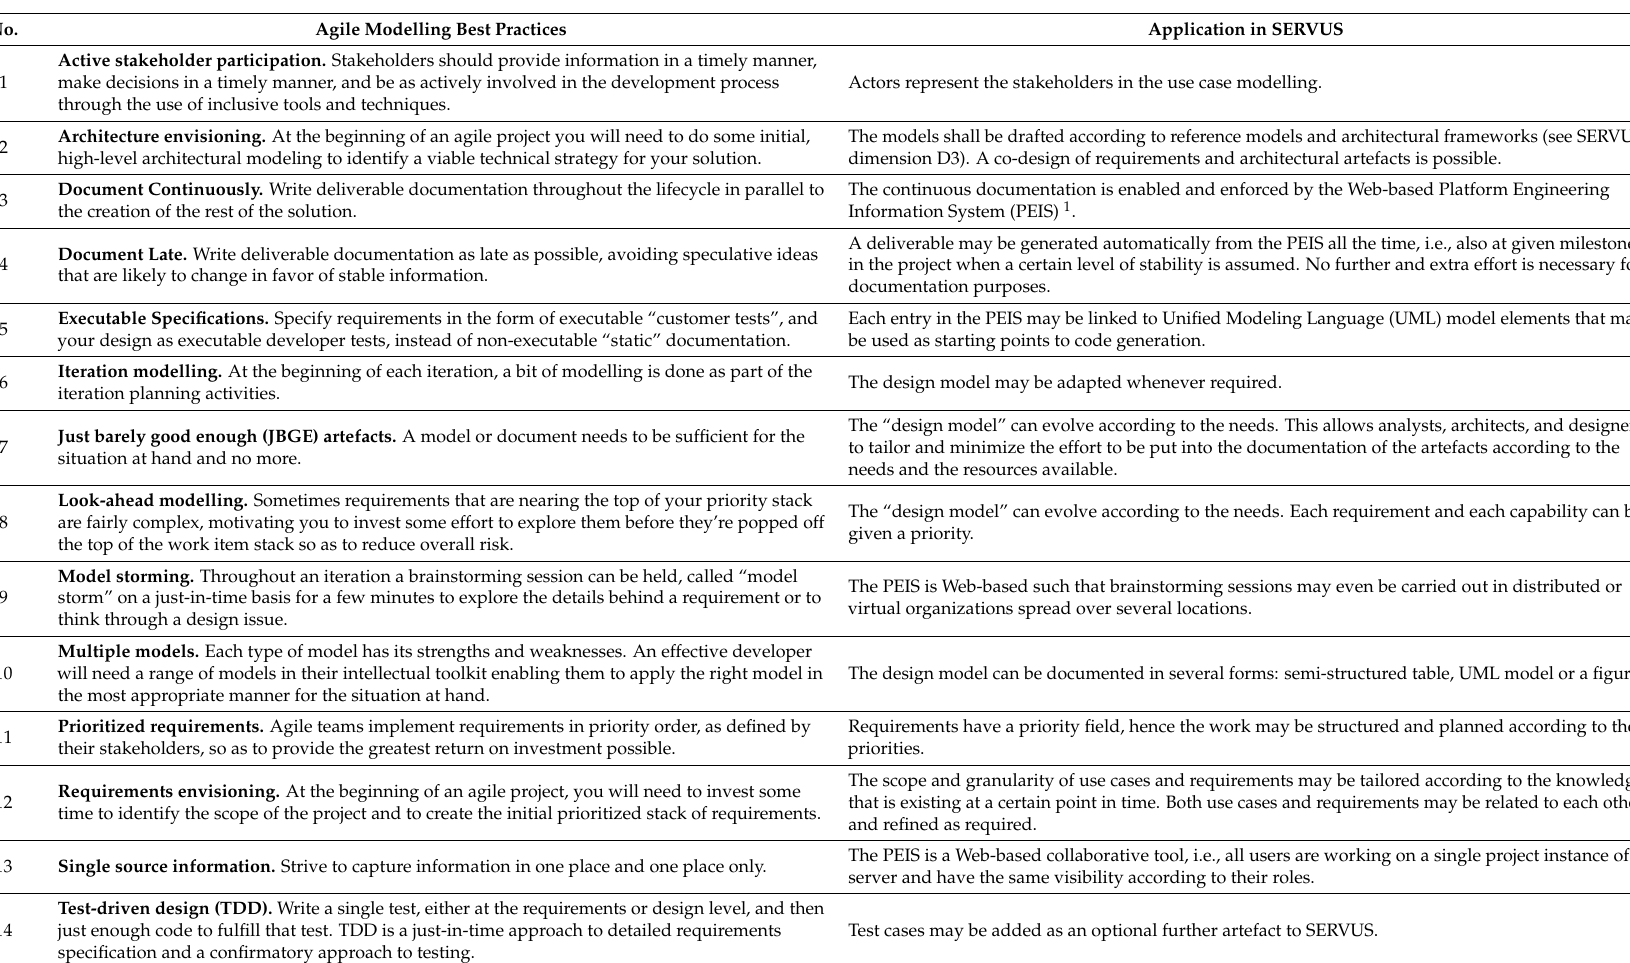
Table 1. Application of Agile Modelling Best Practices in